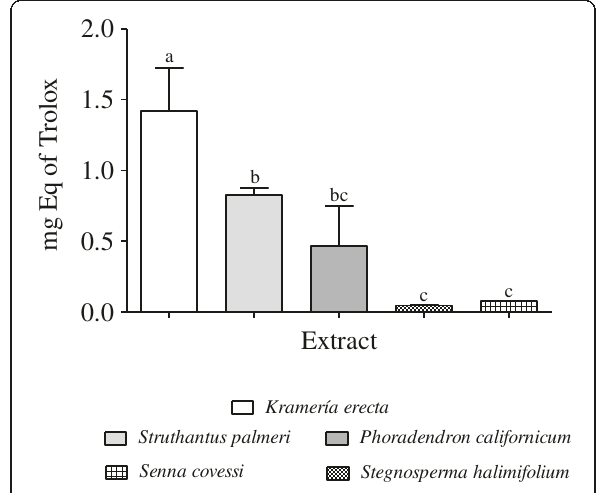
Figure 2 Ferric reducing antioxidant power assay (FRAP assay) of Krameria erecta , Struthanthus palmeri , Phoradendron californicum , Senna covesii and Stegnosperma halimifolium methanolic extracts. The results are expressed as mg Eq of Trolox. The bars represent the standard deviation (mean ± SD; n = 3). Significant differences (p < 0.05) are indicated by different letters (a – c).